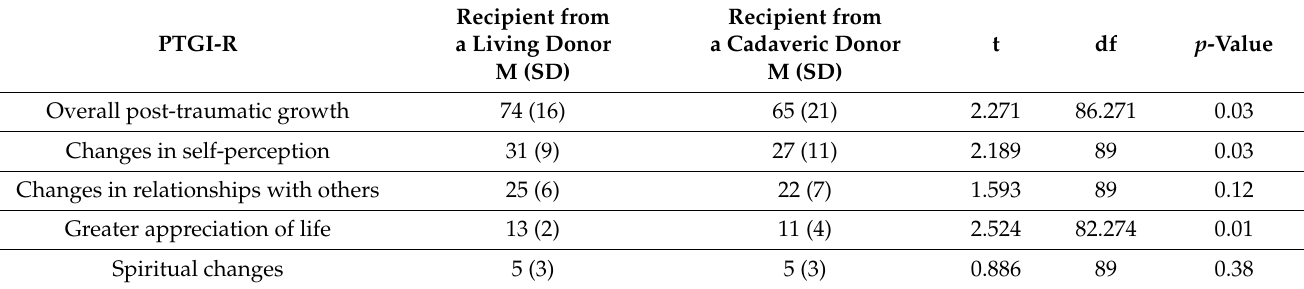
Table 1. Differences in the level of post-traumatic growth between recipients from a living donor and recipients from a cadaveric